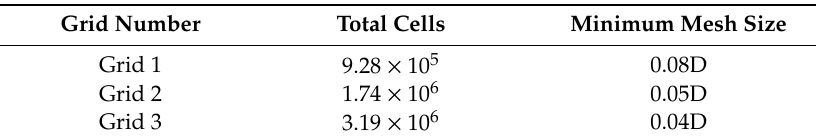
Table 3. Parameters of di ff erent grid.